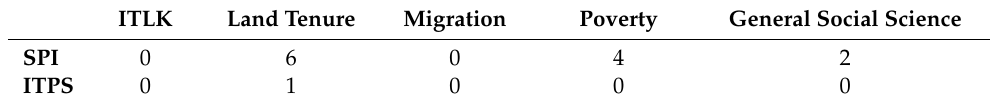
Table 3. Co-occurrences between ‘gender’ and other categories. ITLK Land Tenure Migration Poverty General Social Science SPI 0 6 0 4 2 ITPS 0 1 0 0